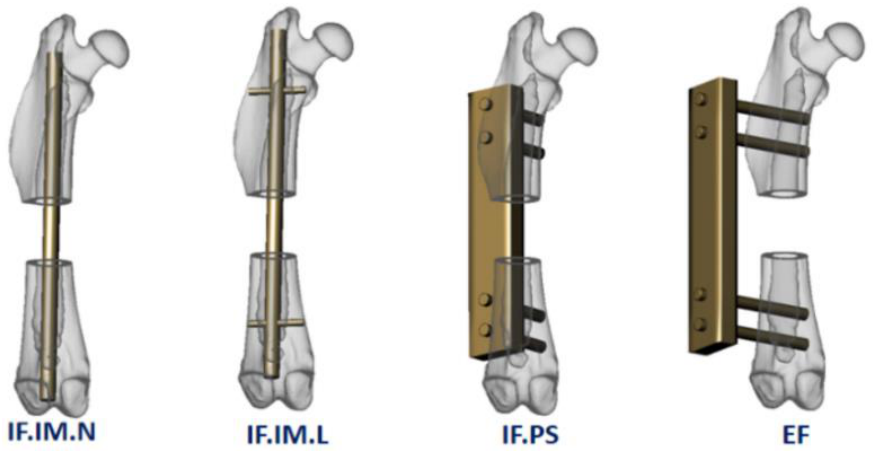
Figure 6. Classification of fixation devices. Note: IF.IM.N : internal fixation, intramedullary, non-